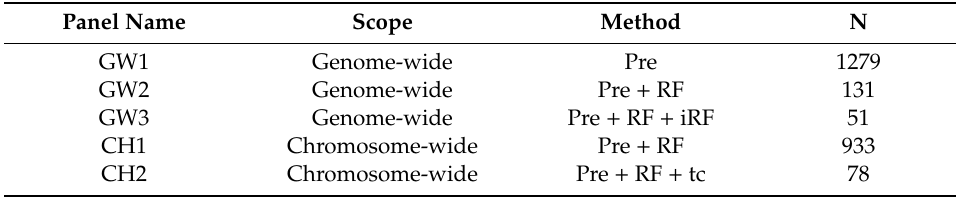
Table 1. Characteristics of the ancestry informative marker panels. The data processes used for marker selection were: preselection (Pre), Random Forest (RF), iterated Random Forest (iRF), and top-markers choice (tc). N is the number of SNPs in each panel. The SNP distribution per chromosome can be found in Supplementary Table S1.